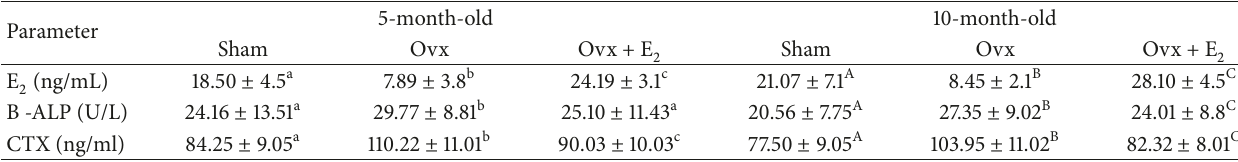
Table 5: The effects of ovariectomy (ovx) and 17 𝛽 -estradiol (ovx + E 2 ) on blood parameters in rats with initial ages of five and ten months. Ovariectomy significantly lowered serum E 2 and increased B-ALP and CTX in both age